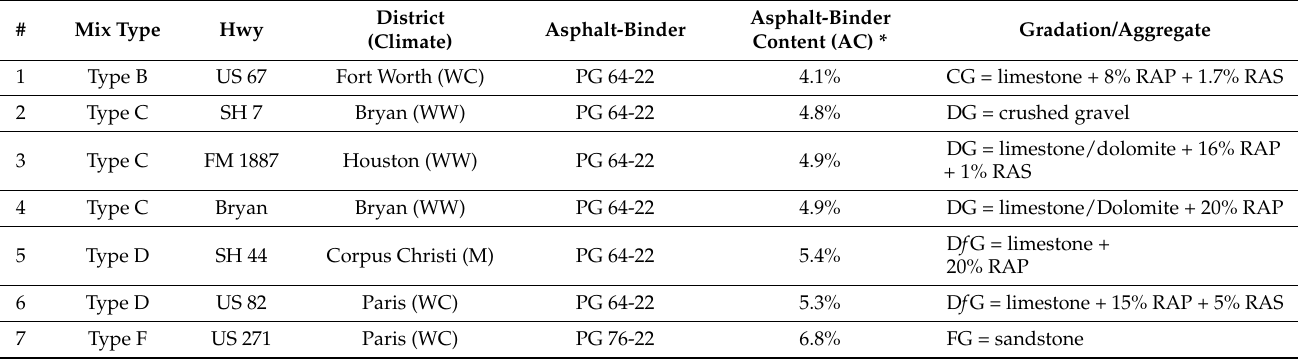
Table 1. HMA Mixes and Volumetric Characteristics.